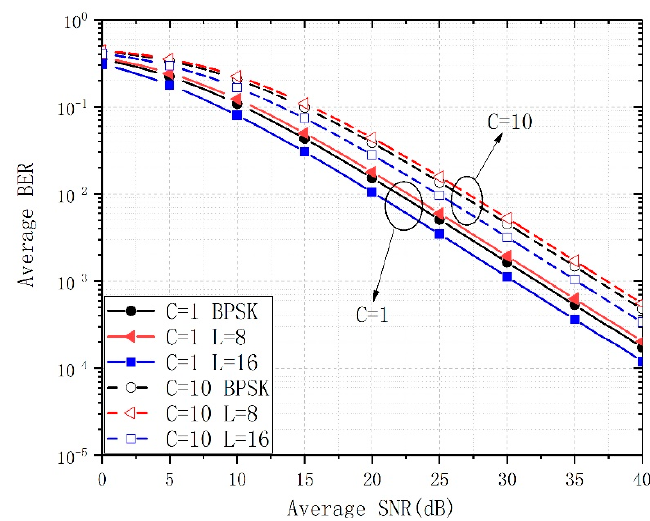
0.4 = α and 0.4 = α and